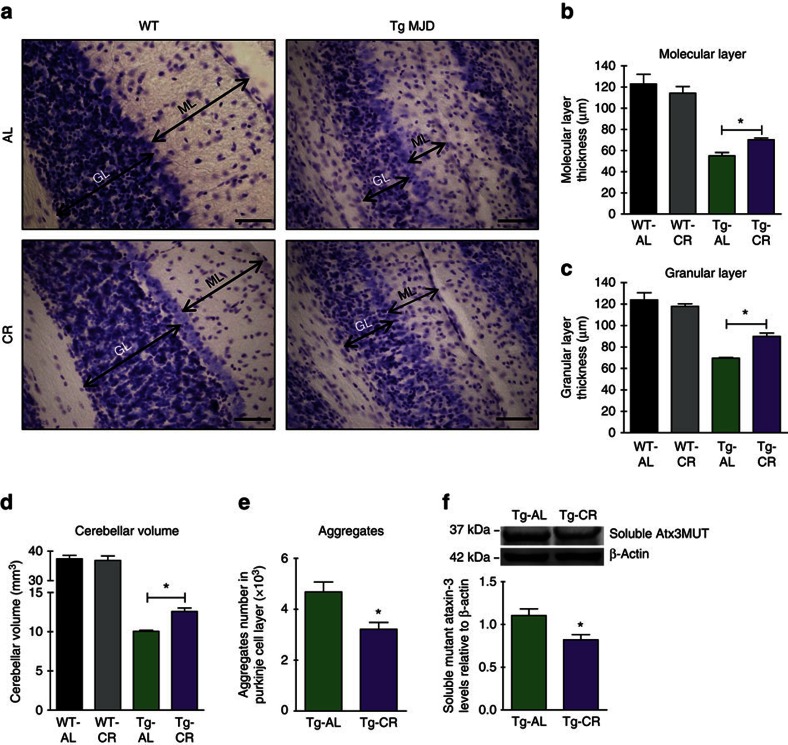
Nine weeks of CR prevents cerebellar neuropathology in Tg MJD mice.(a) Cresyl violet-stained sections demonstrate the thickness of molecular layer (ML) and granular layer (GL) of lobule V of cerebellum in 15-week-old littermate WT and Tg MJD mice in AL or CR diet, quantified in b and c. Scale bar, 50 μm. (d) Quantification of cerebellar volume showed a significantly higher cerebellar volume in calorie-restricted mice. (e) Analysis of the number of mutant ataxin-3 inclusions in the cerebellar Purkinje cells of Tg MJD mice. The total number of aggregates in Purkinje cells is significantly lower in calorie-restricted mice, in comparison with AL mice. (f) Relative levels of the soluble form of mutant ataxin-3 normalized with β-actin were significantly decreased in Tg mice in the CR diet. Data represent mean±s.e.m.; NS P>0.05 and *P<0.05 compared with Tg-AL. (b–d). One-way analysis of variance with Bonferroni's post-hoc test. (e,f) Unpaired Student's t-test. WT-AL n=3; WT-CR n=4; Tg-AL n=4; Tg-CR n=4.